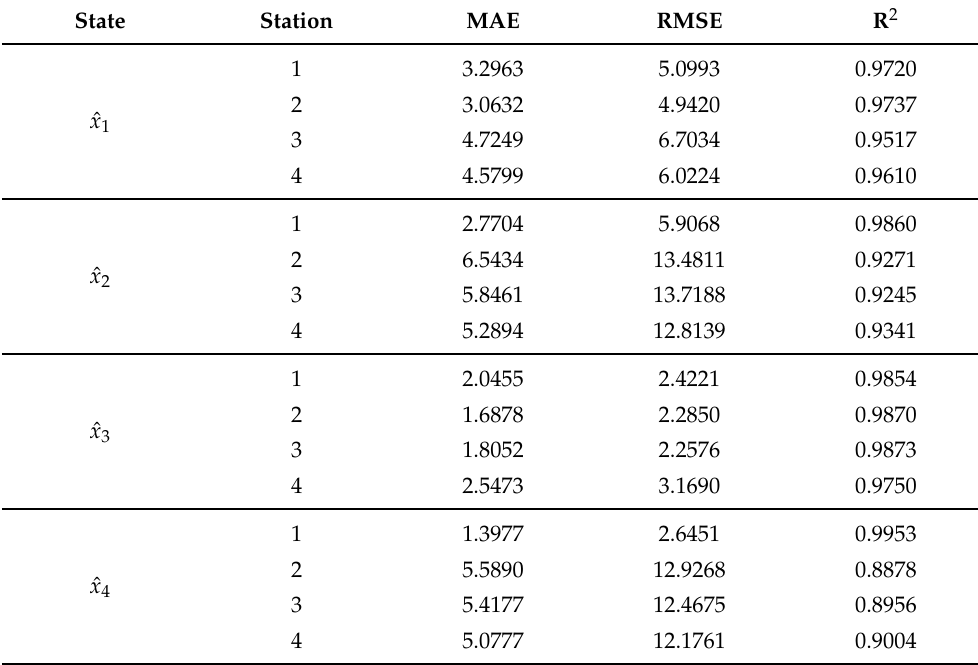
Table 2. Kalman filter-based estimation errors on the test